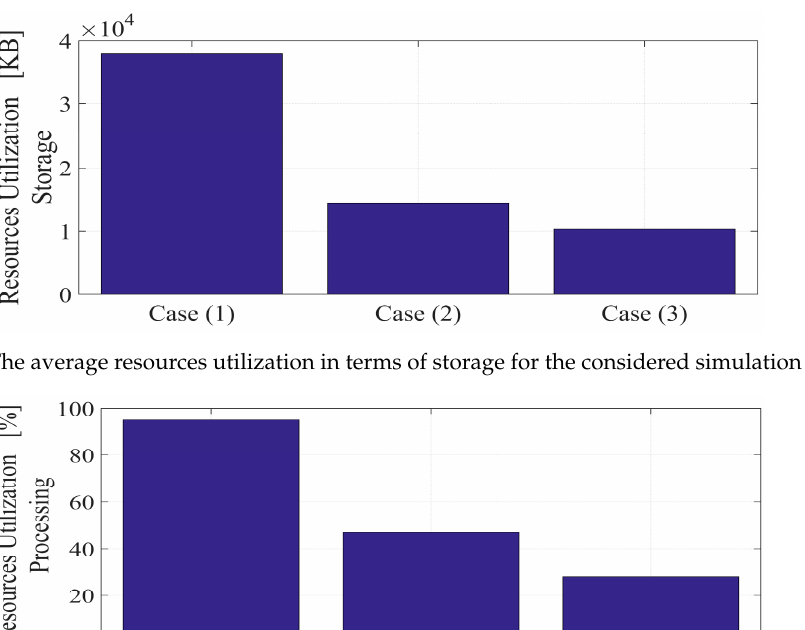
Figure 8. The average resources utilization in terms of processing for the considered simulation cases.